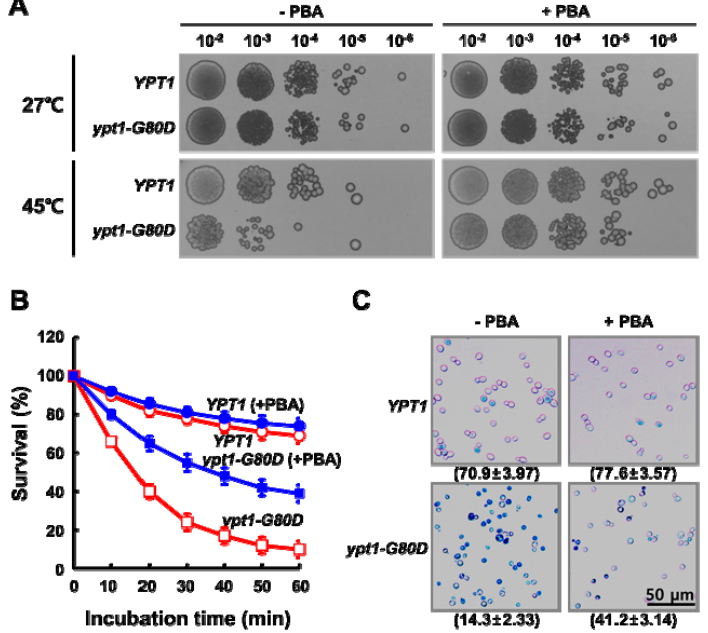
Figure 5. PBA Increases the Thermo Tolerance of ypt1-G80D Cells. ( A ) Yeast spot assay. Yeast cells (5 × 7 cells/mL) were grown in YPD medium and incubated at 27 °C or 45 °C for 1 h in the presence (+PBA) or absence (-PBA) of 1 mM PBA. Samples of the YPT1 and ypt1-G80D cells were